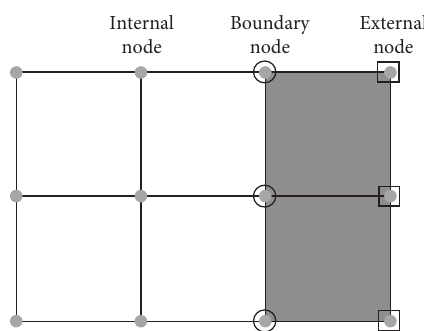
Figure 7: Node classification of subregion.